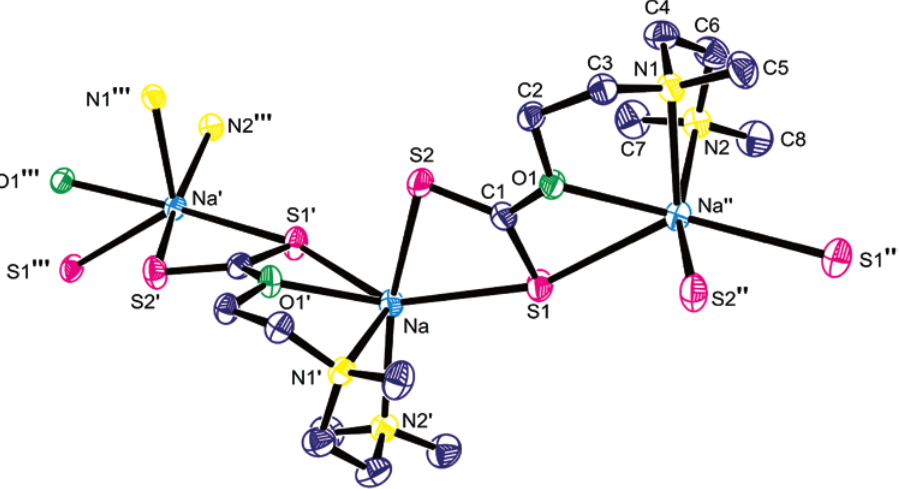
Figure 1: The asymmetric unit of 1 showing the labelling scheme used; thermal ellipsoids are at the 50% probability level. Symmetry opera- tions: ′ 3/2-x, 1/2+y, z; ″ 3/2-x, y-1/2, z; ′ ″ x, 1+y, z.